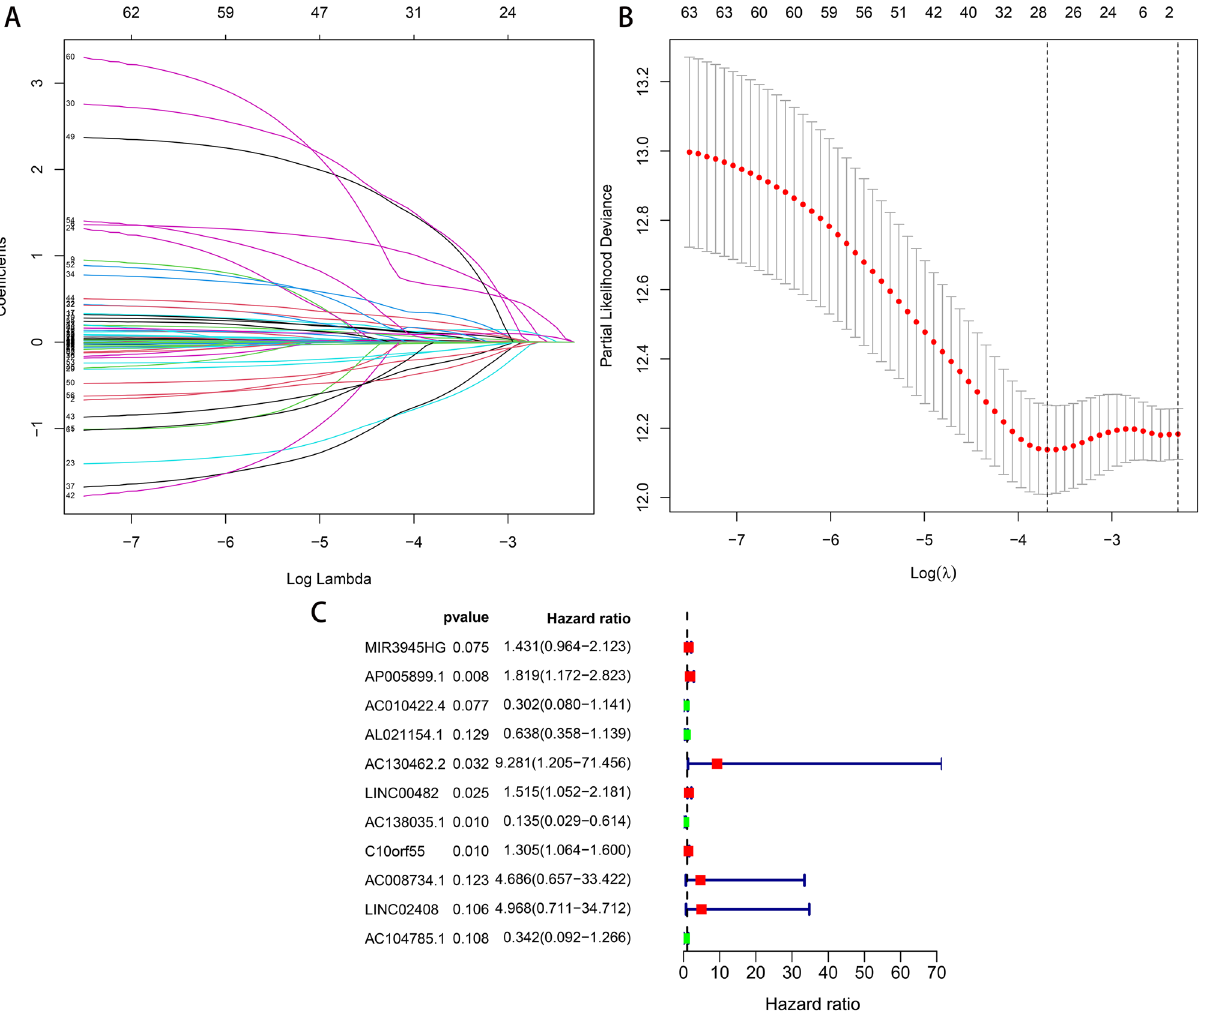
Figure 2. Construction of the pyroptosis-related lncRNA prognostic signature in LSCC patients. ( A ) Selection of the optimal parameter (lambda) via 5 times cross-validation. ( B ) LASSO coefficient profiles of 28 pyroptosis- related lncRNAs. ( C ) 11 lncRNAs were identified for constructing A signature by multivariate Cox ratio hazard regression analysis. lncRNA long non-coding RNAs, LSCC lung squamous cell carcinoma, LASSO least absolute shrinkage and selection